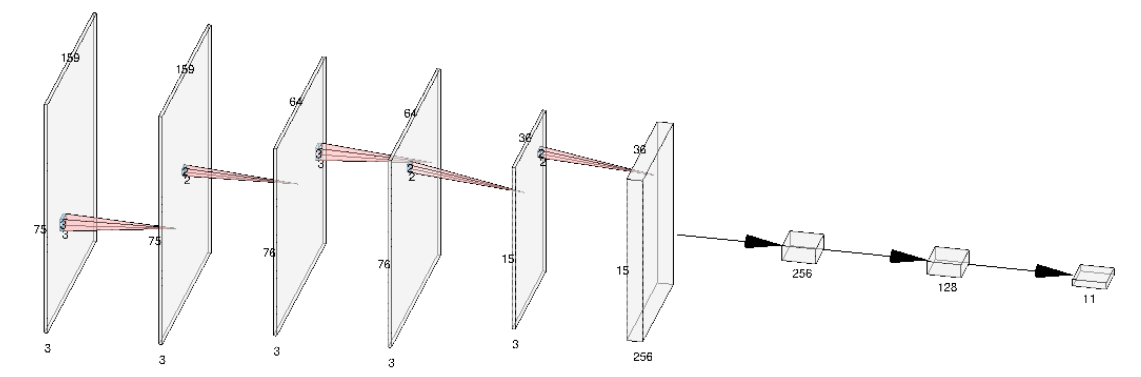
Figure 4. A visual illustration of the Convolutional Neural Network (CNN) architecture of Reference [26], that has been adopted in order to recognize actions using as input the activity